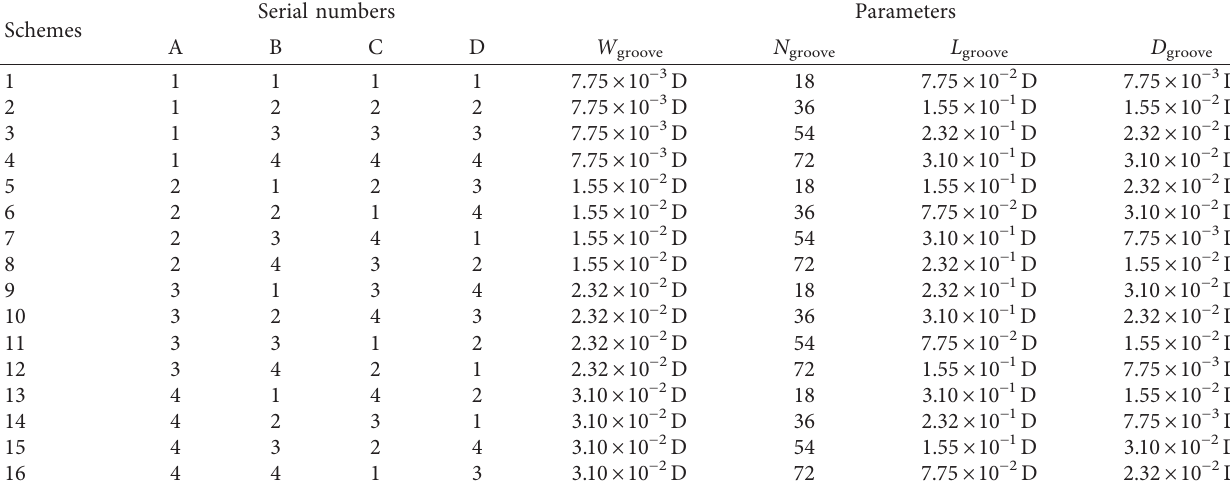
Table 2: L 4 ) orthogonal experiment 16 (4